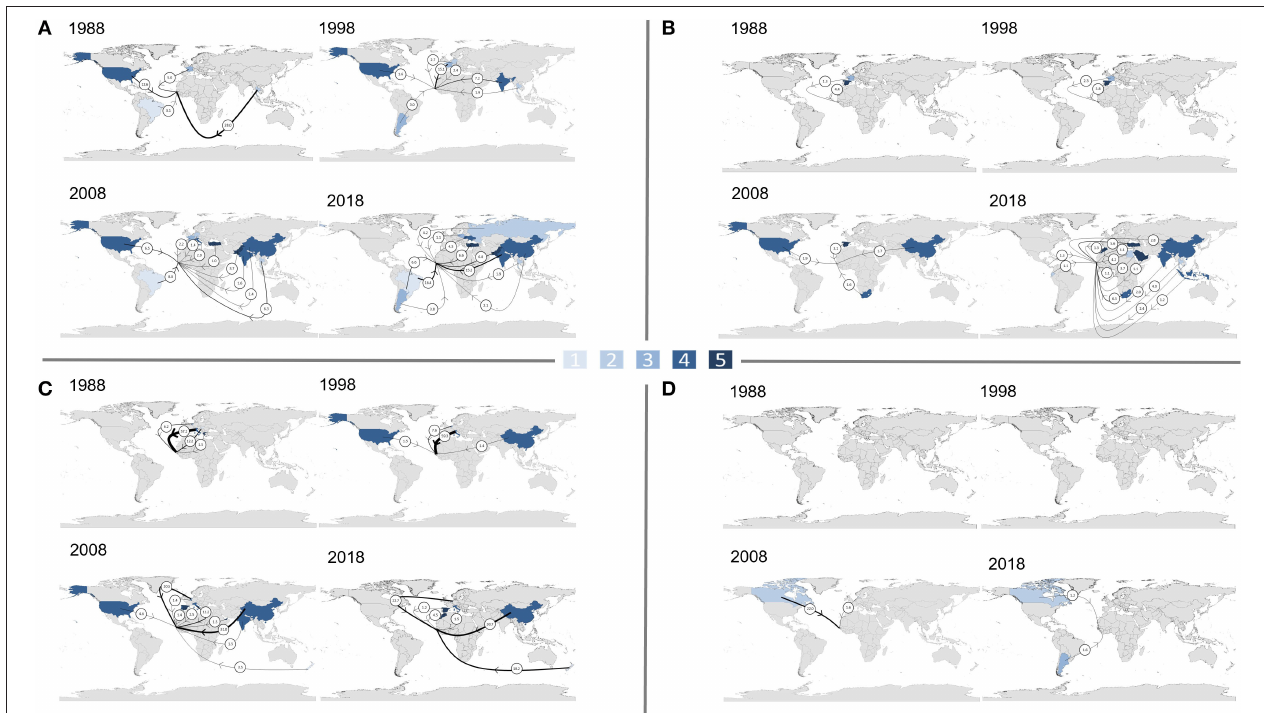
FIGURE 5 | The projected water stress of trade partners (ratio of total water withdrawals to total renewable supply, WRI Aquaduct) contributing ≥ 1% of supply of (A) cereals (B) fruits (C) vegetables (D) pulses, in 1988, 1998, 2008, and 2018. Amount the imported crop contributes to supply is represented by arrow thickness (not to scale) and numbers (%). There are five water stress severity categories: [1] Low ( < 10%); [2] Low to medium (10–20%); [3] Medium to high (20–40%); [4] High (40–80%); [5] Extreme ( > 80%). The darker the color, the more water stressed a country is projected to be in 2040, in a business-as-usual